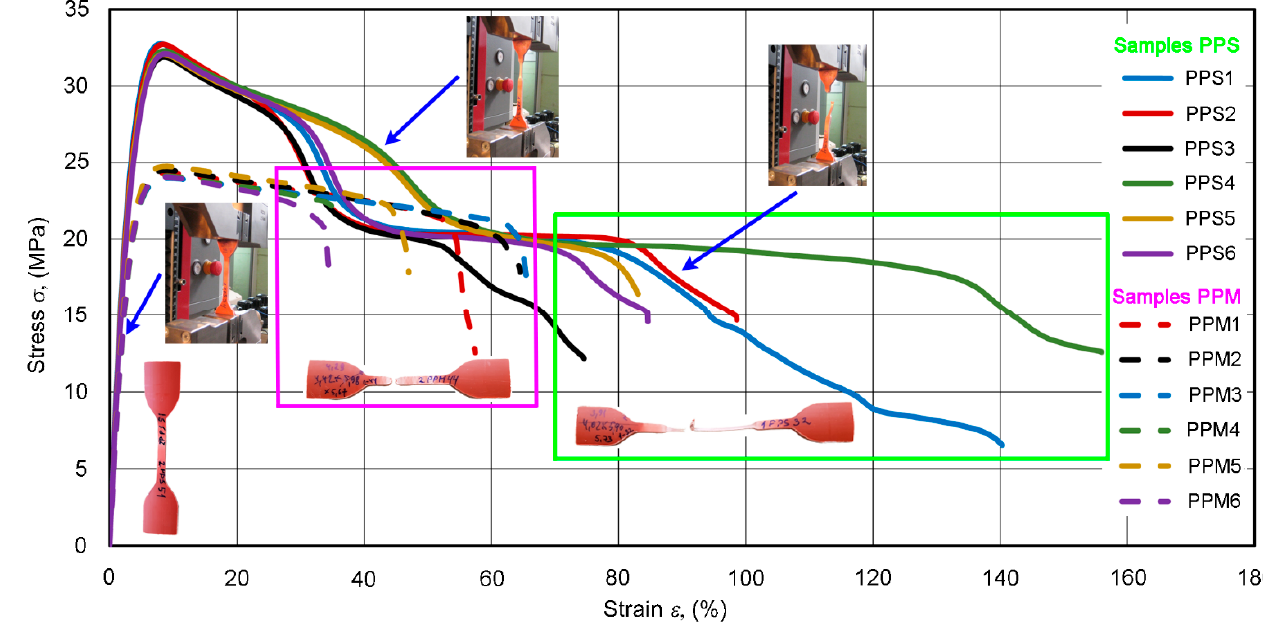
Figure 7. Stress–strain curves σ – ε of PPS and PPM specimens.